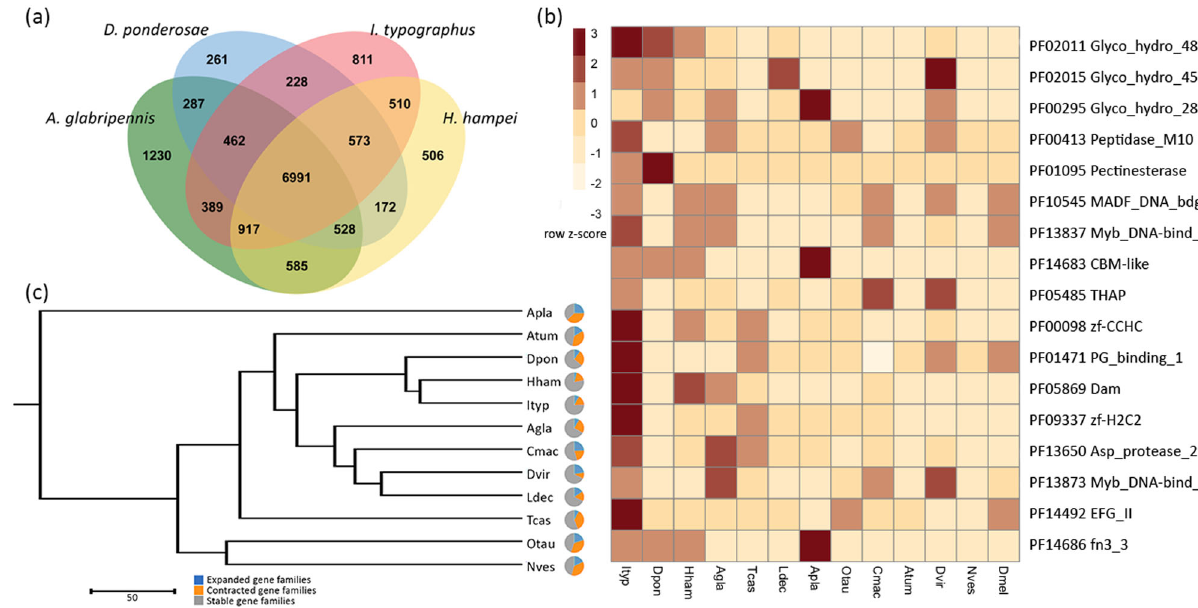
Fig. 3 Gene ortholog analysis. a Venn diagram of orthologous genes shared between Ips typographus, Dendroctonus ponderosae, Hypothenemus hampei (three bark beetles) and Anoplophora glabripennis (polyphagous cerambycid wood-borer). b Expanded protein families in I. typographus compared with other sequenced Coleoptera species and Drosophila melanogaster . Full names of protein families and corresponding PFam identi fi ers are given in Supplementary Table 7. Cell colours indicate the number of standard deviations from the mean of each domain count for all species. c Phylogenetic relationship of 11 Coleoptera species inferred from orthologous gene groups and including the number of expanded and contracted orthologous groups as identi fi ed by the CAFE analysis. Species abbreviations: Atum, Aethina tumida ; Apla, Agrilus planipennis ; Agla, Anoplophora glabripennis ; Cmac, Callosobruchus maculatus ; Dpon, Dendroctonus ponderosae ; Dvir, Diabrotica virgifera ; Hham, Hypothenemus hampei ; Ityp, Ips typographus ; Ldec, Leptinotarsa decemlineata ; Nves, Nicrophorus vespilloides ; Otau, Onthophagus taurus ; Tcas, Tribolium castaneum ; Dmel, Drosophila melanogaster . Scale bar represents 50 million years.